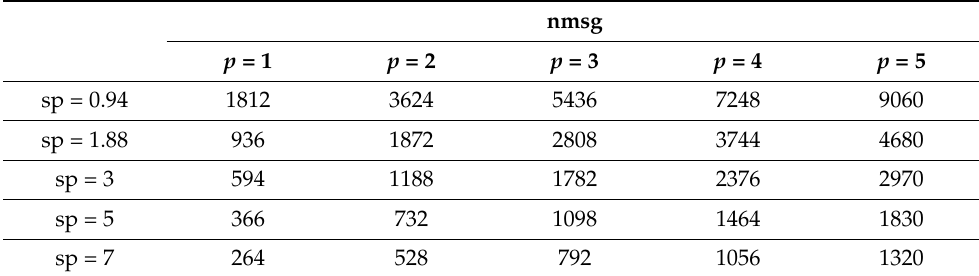
Table 4. Effect of the sampling period sp and the number of parks p on the number of messages collected during 300 s, with the total number of sensors ns =